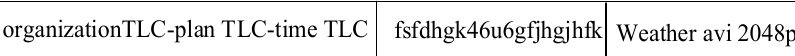
Figure 6. Example of the naming of “hierarchical ‐ flat ‐ attribute” based on TLC structure.